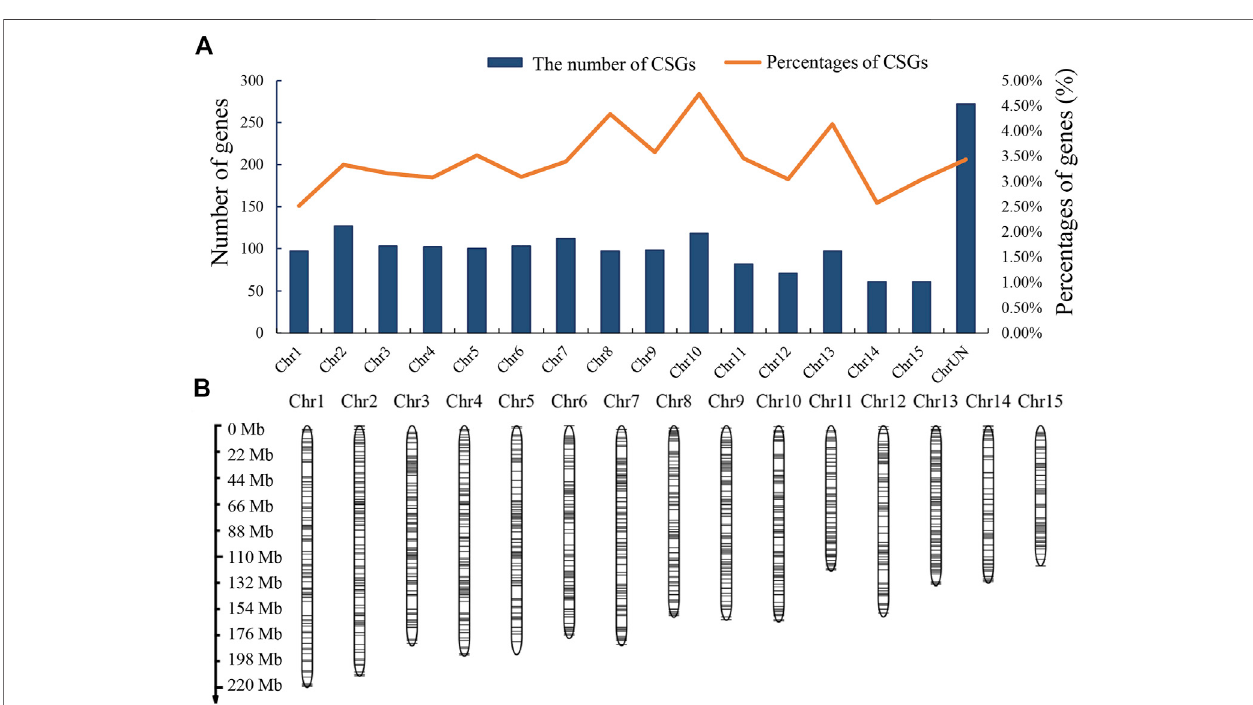
FIGURE4| Camellia -speci fi cgenes(CSGs)distributiononchromosomes. (A) ThenumbersofCSGsoneachchromosomeof Camelliasinensis var. sinensis .Both numbers and percentages are shown. (B) Chromosomal distribution of the identi fi ed CSGs. Black horizontal lines represent CSGs.